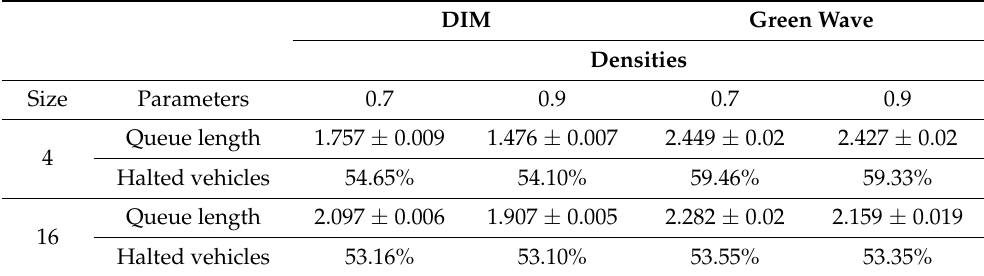
Table 3. Queue lengths and halted vehicles in cities with 700 m between intersections.